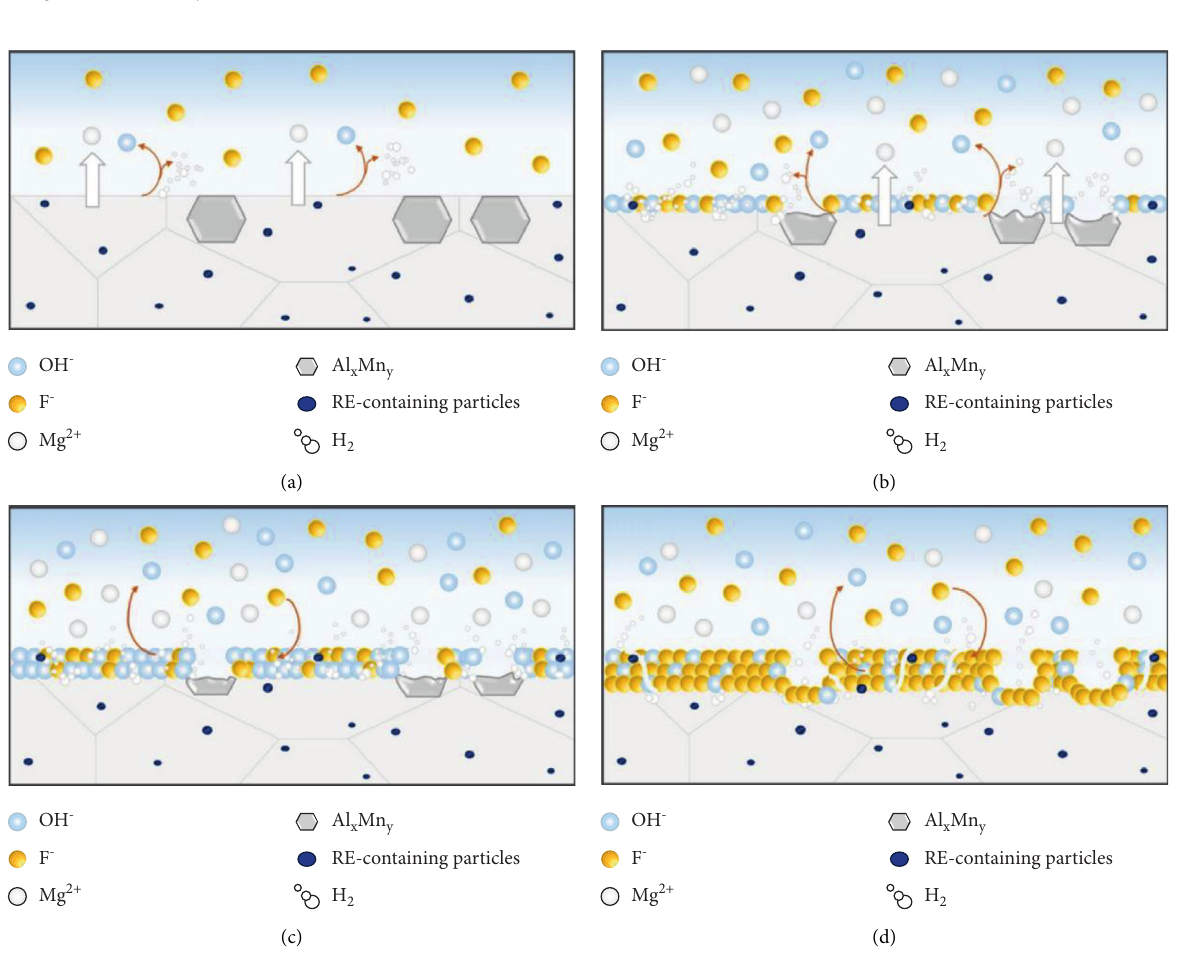
Figure 1: Mechanism of formation of the fluoride coating on the AZ31 magnesium alloy